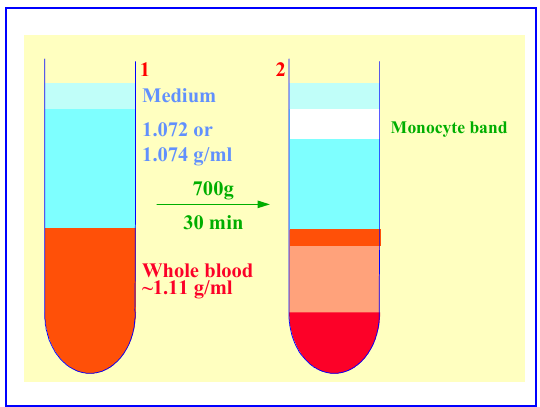
FIGURE 2 . Separation of monocytes by flotation through a low-density barrier from whole human blood: before (1) and after (2) centrifugation.